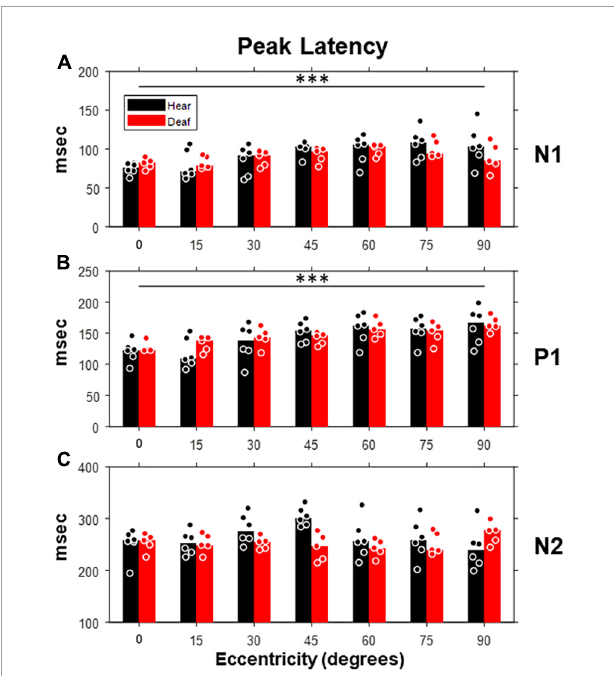
FIGURE6 Peak latencies of three VEP components (N1, P1, and N2) as a function of stimulus eccentricity. Same layout of panels (A–C) as in Figure 5 but for peak latency. Dot, individual subject; bar, median; ***p < 0.001 for main effect of eccentricity.